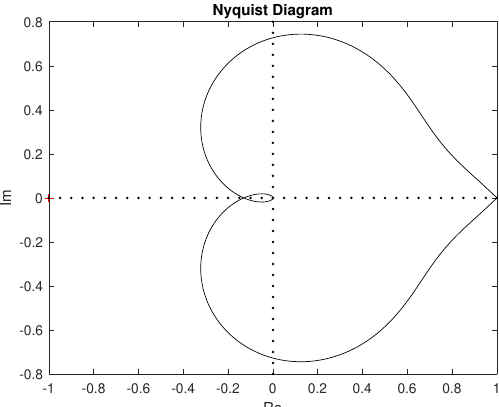
Figure 10. Nyquist Diagram for Example 2